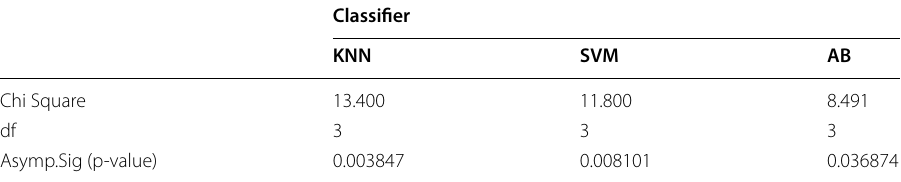
Table 7 The results of the Friedman statistics test Classifier KNN SVM AB Chi Square 13.400 11.800 8.491 df 3 3 3 Asymp.Sig (p-value)